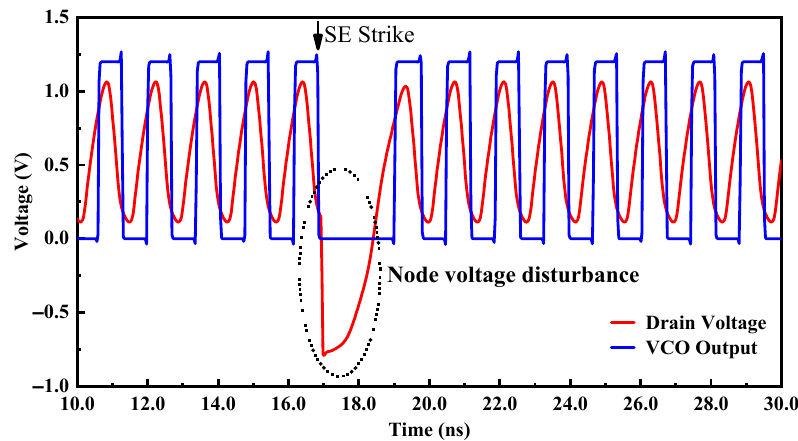
Figure 4. Simulation results of the node voltage disturbance and the VCO output.